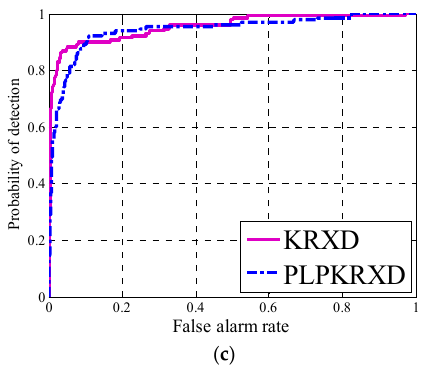
Figure 11. Receiver operation characteristic (ROC) curves obtained by the Kernel-RX detector (KRXD) and the PLP-KRXD on three HSI datasets. ( a ) Synthetic dataset; ( b ) Pavia Center dataset; ( c ) San Diego Airport dataset.